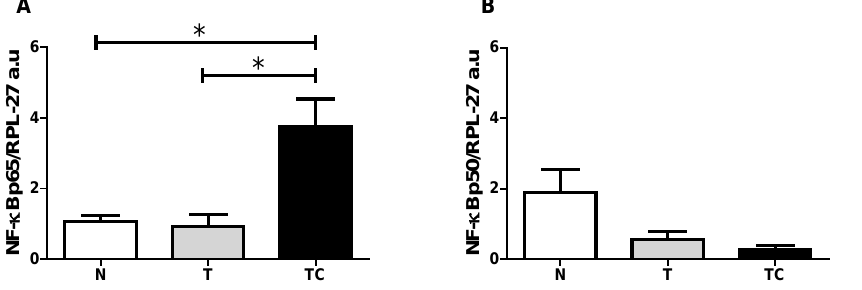
Figure 3. Subcutaneous adipose tissue NF-κBp65 and NF-κBp50 gene expression. ( A ) NF-κBp65/RPL-27 gene expression; ( B ) NF-κBp50/RPL-27 gene expression. Data expressed as mean ± standard error; *: p <